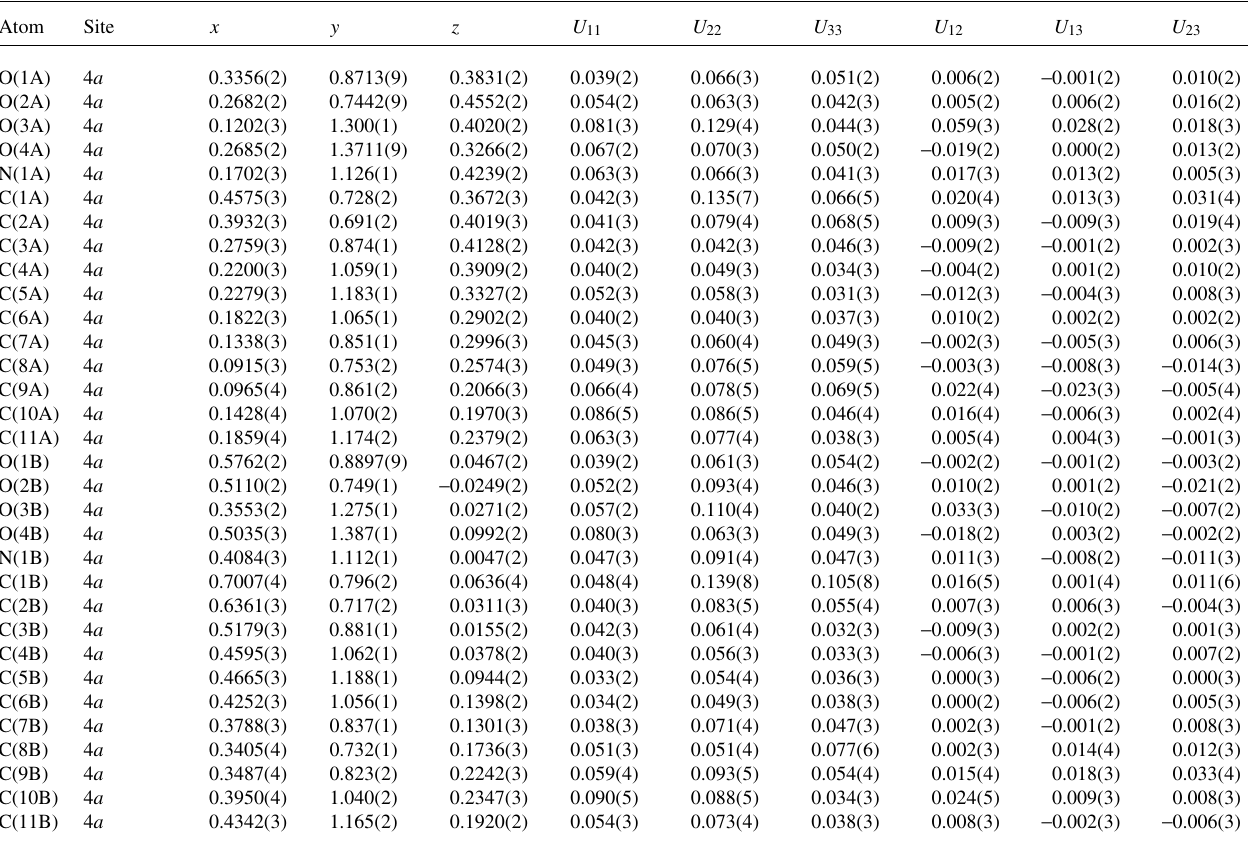
Table 3. Atomic coordinates and displacement parameters (in Å 2 )